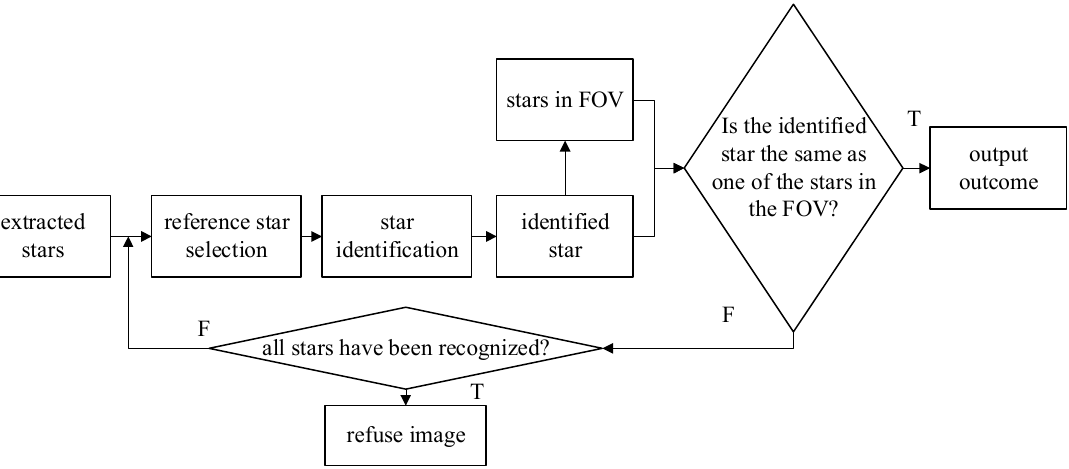
Figure 6. Traditional validation method requiring iterative validation.